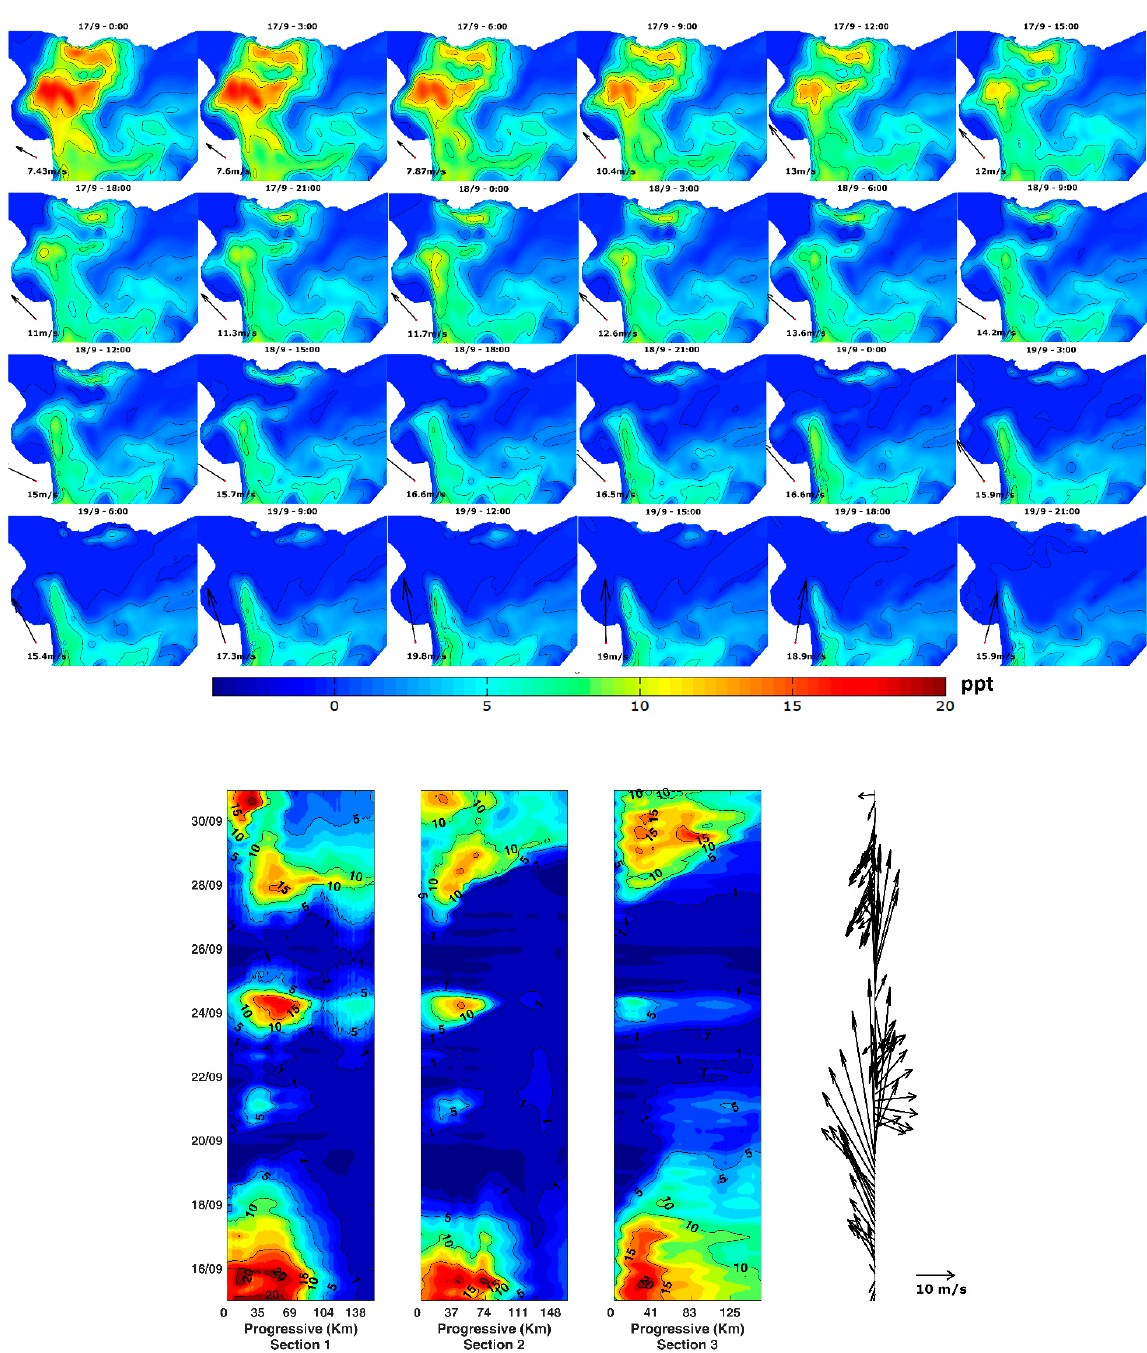
Figure 11. Stratification for a storm with main wind direction from the southeast, which occurred in September 2012. Upper panel: temporal evolution of the stratification field (ppt; time step 3 h). Time increasing from left to right and upper to lower panels. All maps are in geographic coordinates between Lat ( − 36.9, − 34.7) and Long ( − 57.4, 54.2). Lower panel: Hovmoller diagram along longitudinal sections defined in Figure 7; wind evolution on the right. Y-axis shows the date